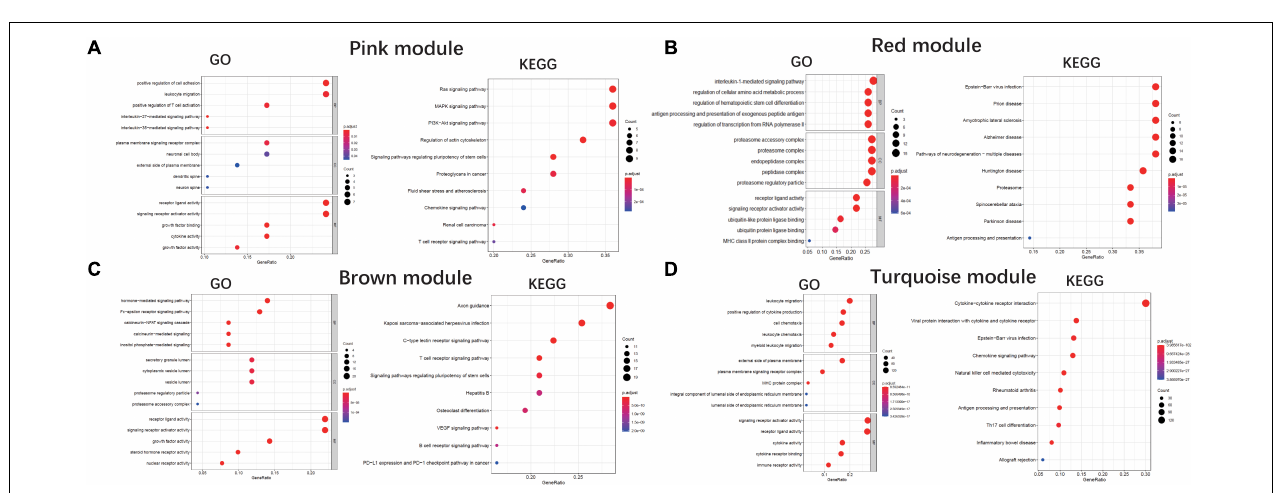
FIGURE 3 | Weighted gene correlation network analysis (WGCNA). (A) Analysis of the scale-free network for various soft-thresholding powers ( β ). A power with the degree of scale independence > 0.9 was considered suitable for constructing the network. (B) Identification of co-expression gene modules. The branches of the dendrogram cluster into 11 modules and each one was labeled in a unique color. (C) A heatmap showing the correlation between each module eigengene and phenotype. Four modules were positively correlated with ALS-namely, pink, turquoise, brown, and red modules. Red indicates positive correlation and green indicates negative correlation. (D) Scatter plot of module eigengenes in the pink, red, brown, and turquoise modules. All these four modules significantly correlated with ALS ( p < 0.05).